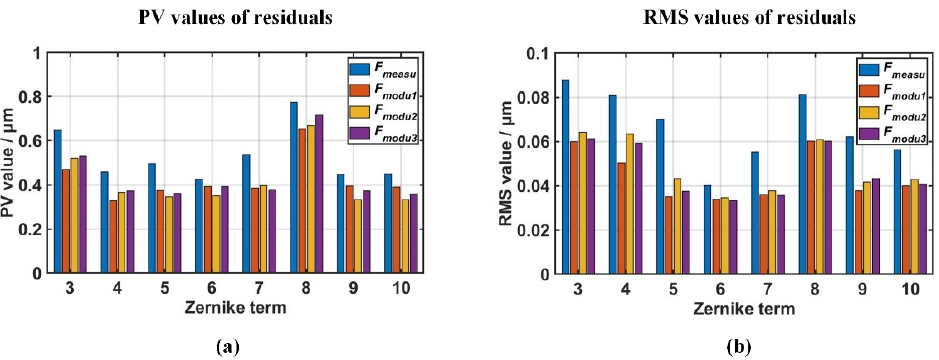
Figure 8. ( a ) PV values and ( b ) RMS values of correction residuals of the 3rd–10th Zernike